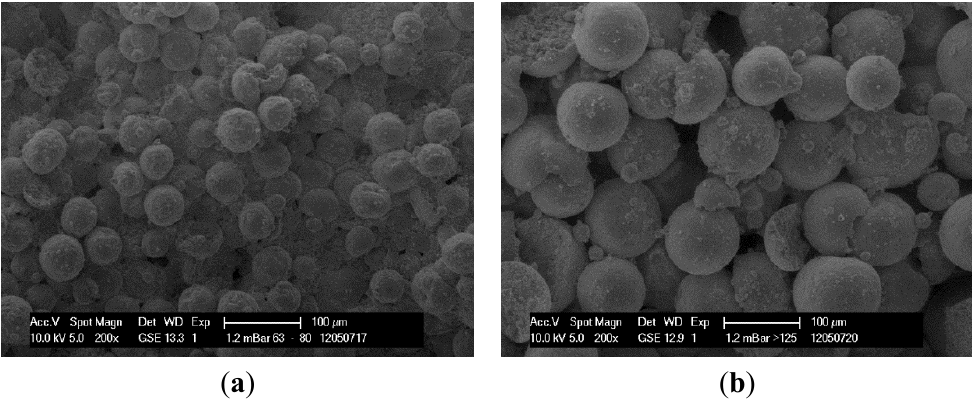
Figure 6. SEM image of specimen made of fraction 63–80 ( a ), SEM image of specimen made of fraction >125 ( b